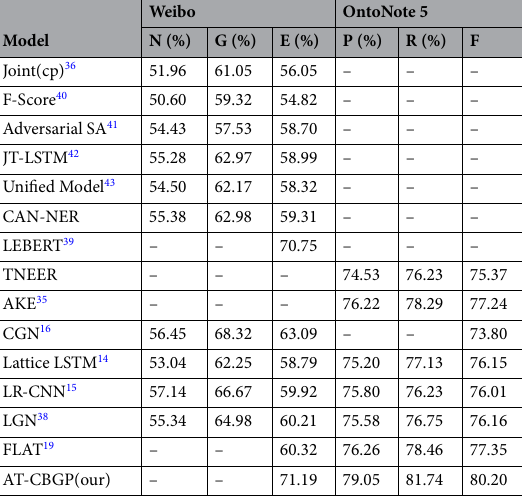
Table 4. Experiment results on Weibo & OntoNote 5.